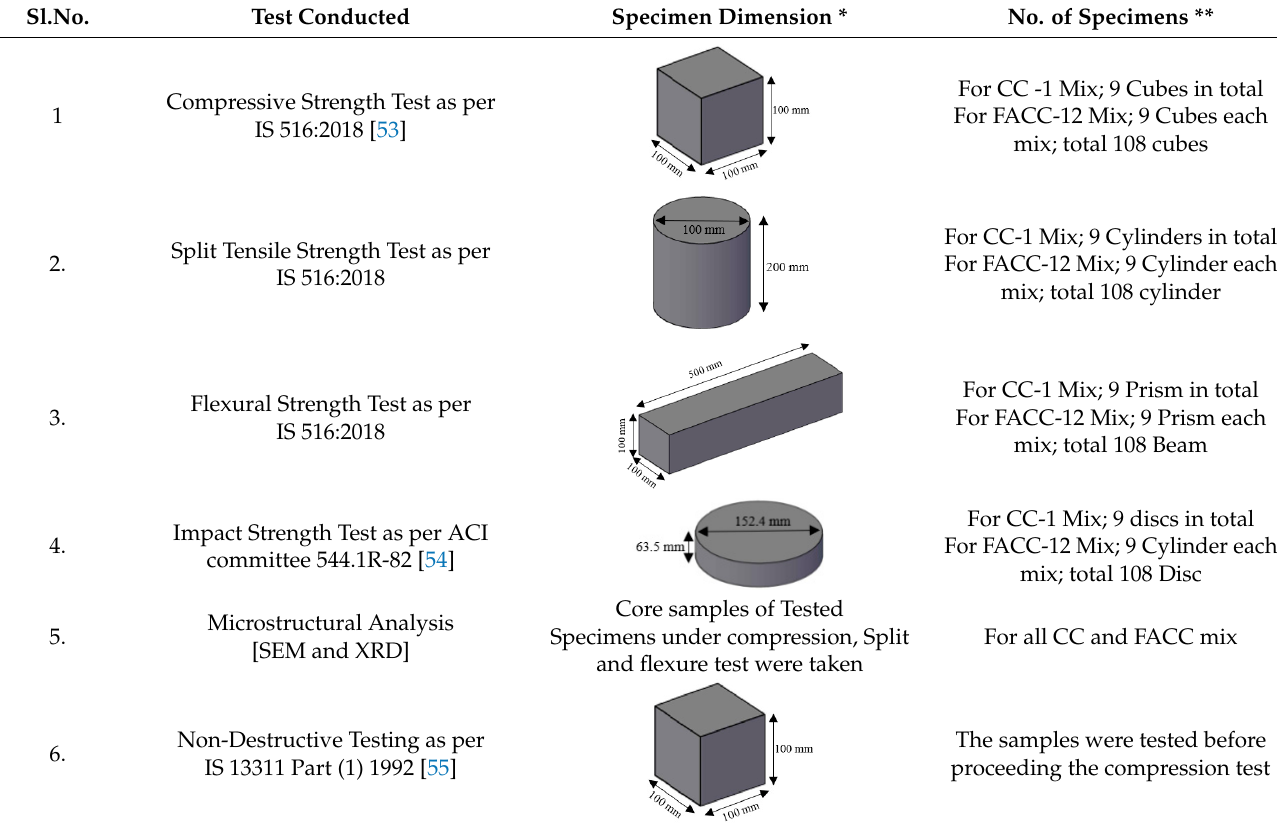
Table 3. Experiments Conducted and Number of Samples Cast in this Study. Sl.No.